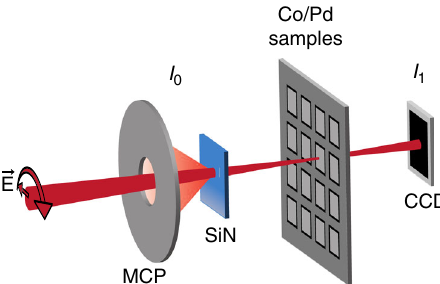
Fig. 1 Experimental setup for X-ray absorption spectroscopy. The setup was implemented at the Linac Coherent Light Source (LCLS) X-ray Free Electron Laser (XFEL). It was used to measure X-ray absorption as a function of photon energy and relative orientation of circular X-ray polarization and sample magnetization. The LCLS Delta undulator produced circularly polarized X-rays which were then monochromatized. This resulted in X-ray pulses with 260 meV bandwidth and 39 fs FWHM duration. The total